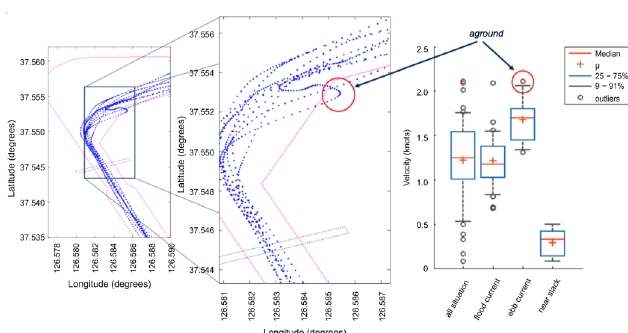
Figure 9. Observed tracks and tide intensity of the accident situation.